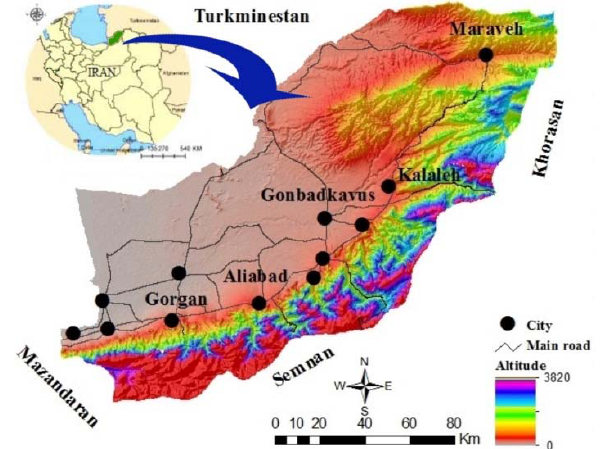
Fig. 1: Study area of Golestan Province, Iran, showing elevational variation across the region.